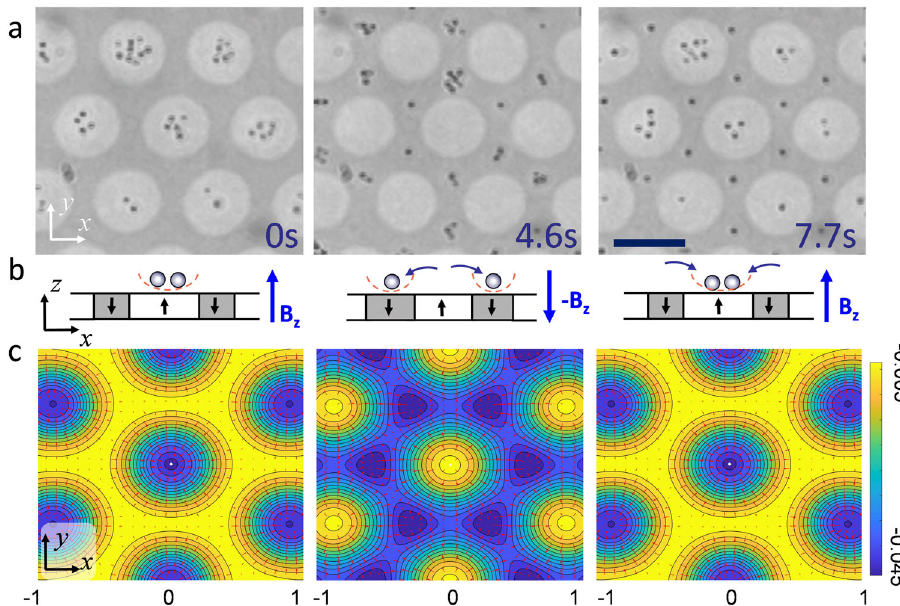
Fig. 6 Field-induced trap escape. a Sequence of images showing the nanoparticle exchange process between 7 nearest bubbles. The particle exchange between the magnetic bubbles (white disks) and the interstitial region (gray) is induced by reversing the fi eld at t = 2.3 s, B z → − B z , and later back to − B z → B z at t = 4.6 s. The scale bar is 10 μ m, see also VideoS2 in the Supporting Information. The error bars result from the statistical average of different simulation data. b Schematics illustrating the particle positions and the applied fi eld in the ( x , z ) plane. c Energy landscape of the magnetic lattice calculated at an elevation z = 1.3 μ m and for an applied fi eld B z = 4.3 mT ( fi rst and third image) and B z = − 2.7 mT (second image) as described in “ Methods ” . Energy minima are colored in blue, maxima in yellow. The red arrows superimposed to the images display the magnetic